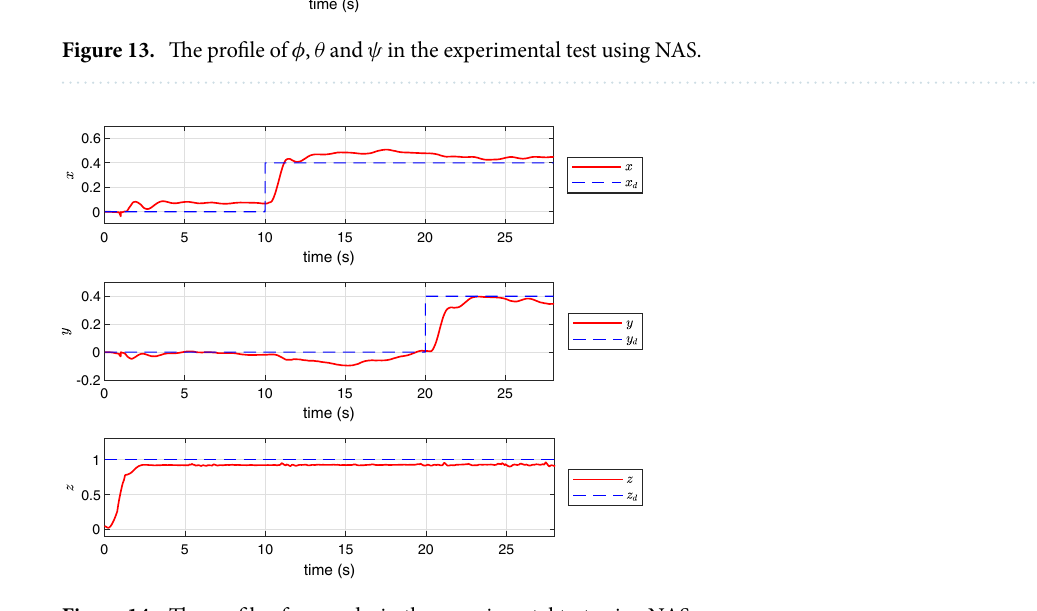
Figure 14. The profile of x , y and z in the experimental test using